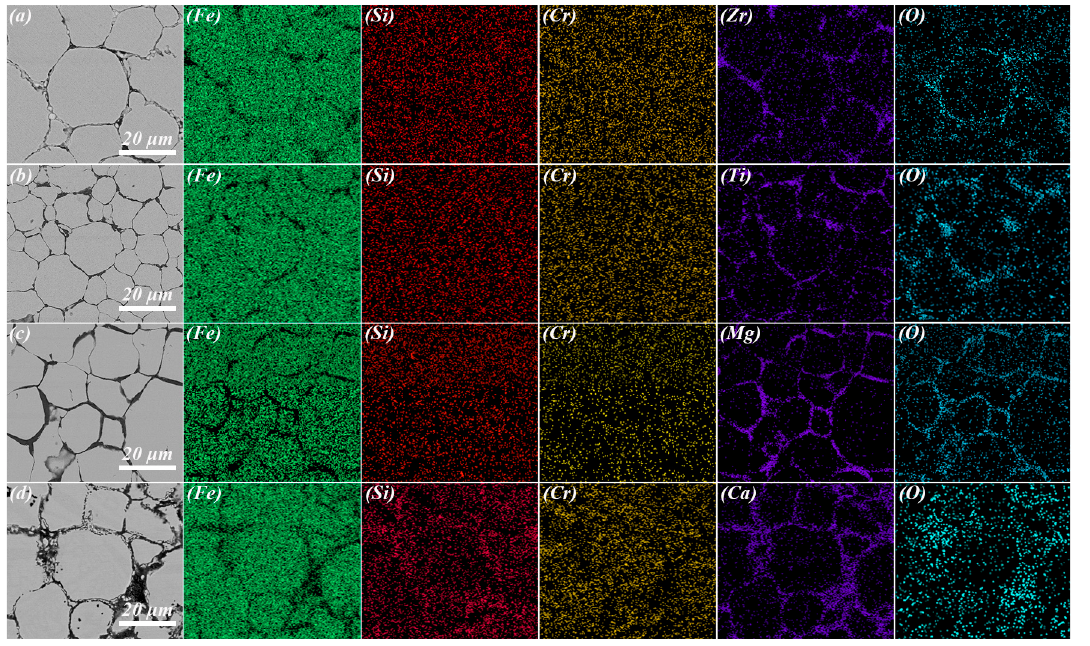
Figure 3. BSE images and EDS energy spectra of Fe-Si-Cr/AO x soft magnetic composite cores: ( a ) Fe-Si-Cr/ZrO 2 , ( b ) Fe-Si-Cr/TiO 2 , ( c ) Fe-Si-Cr/MgO, and ( d ) Fe-Si-Cr/CaO.